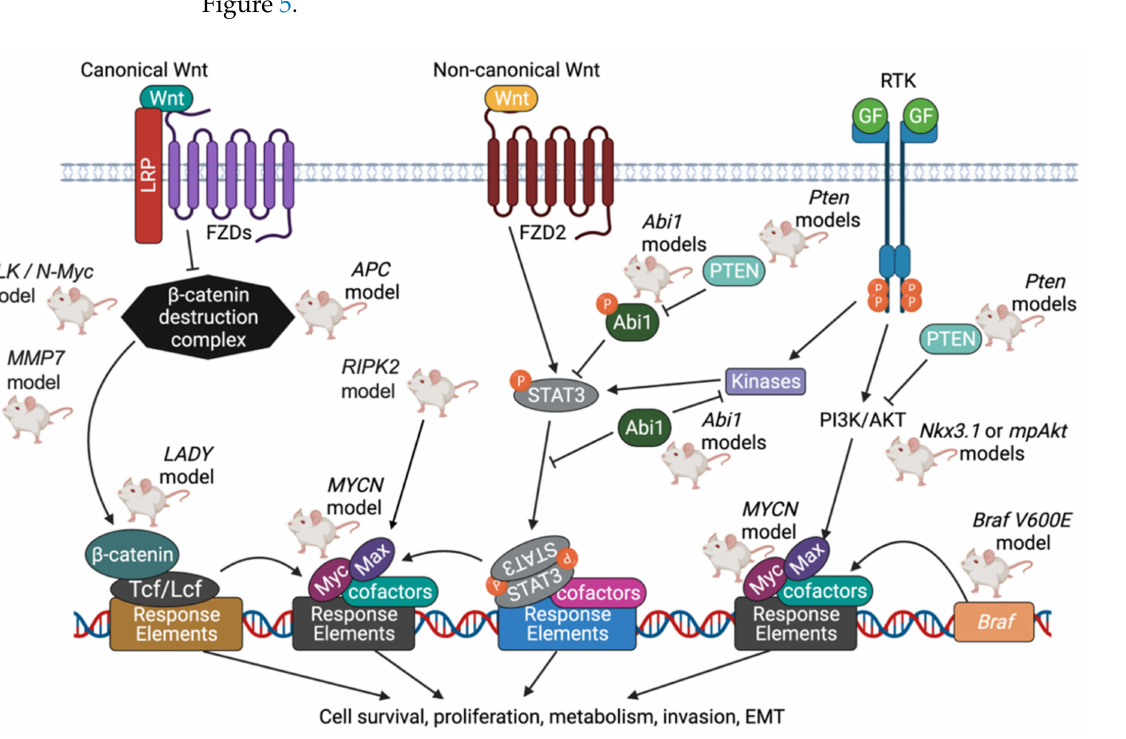
Figure 5. Summary of PCa knockout models driven by MYC and Wnt signaling pathways. Myc family oncoproteins, including c-Myc, N-Myc, and L-Myc, function as growth-promoting transcription factors when expressed in a deregulated fashion. Myc proteins form homodimers with themselves, or as heterodimers with other proteins that share similar structures, before associating with specific DNA response elements. Max, whose levels are increased through the actions of the PI3K pathway, is one protein that associates with Myc. Together, Myc and Max promote advance through the cell cycle by stimulating Cyclin D2/CDK4 and inhibiting p27 Kip1 . In canonical Wnt signaling, Wnt binds to the Frizzled receptor family, and the β -catenin destruction complex (which includes Axin, APC, and GSK-3 β ) is inhibited. The levels of β -catenin accumulate, and β -catenin complexes with DNA binding proteins termed Tcf/Lef, which together enable expression of genes that favor cell survival and proliferation. In non-canonical Wnt signaling, STAT3 (signal transducer and activator of transcription 3) is activated in response to the binding of Wnt to Frizzled receptors. Proteins such as Abi1 inhibit STAT3 from entering the nucleus and acting as an oncogenic transcription factor [135]. Created with